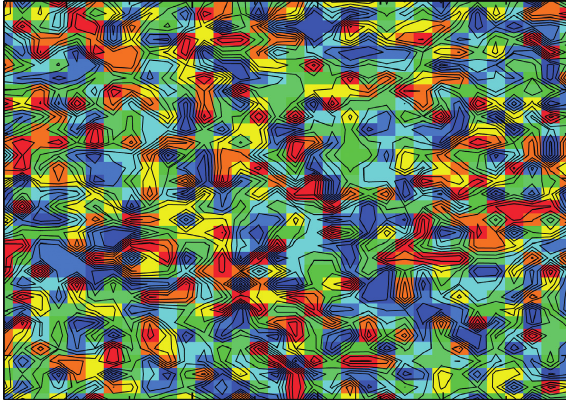
Figure 8: Urban nuclear density